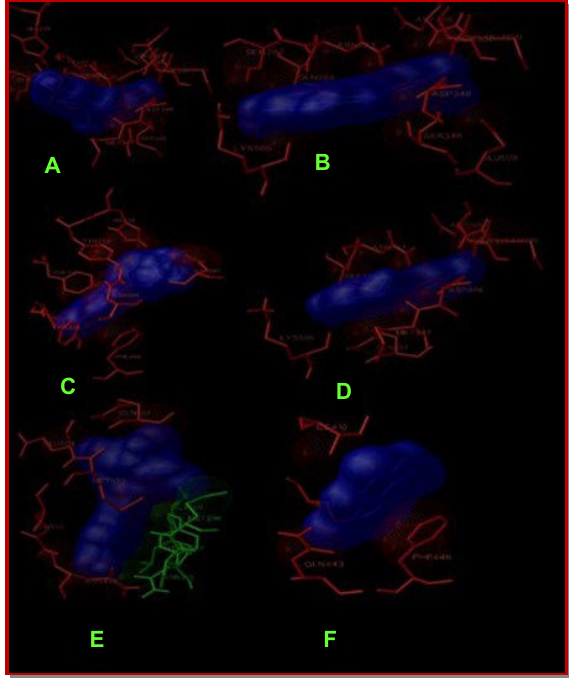
Figure 3: Binding orientations of phosphodiesterase enzyme (3HMV) with the ligands (a Butein, b Diosmetin, c Fisetin, d Tricetin, e Tricin, and f